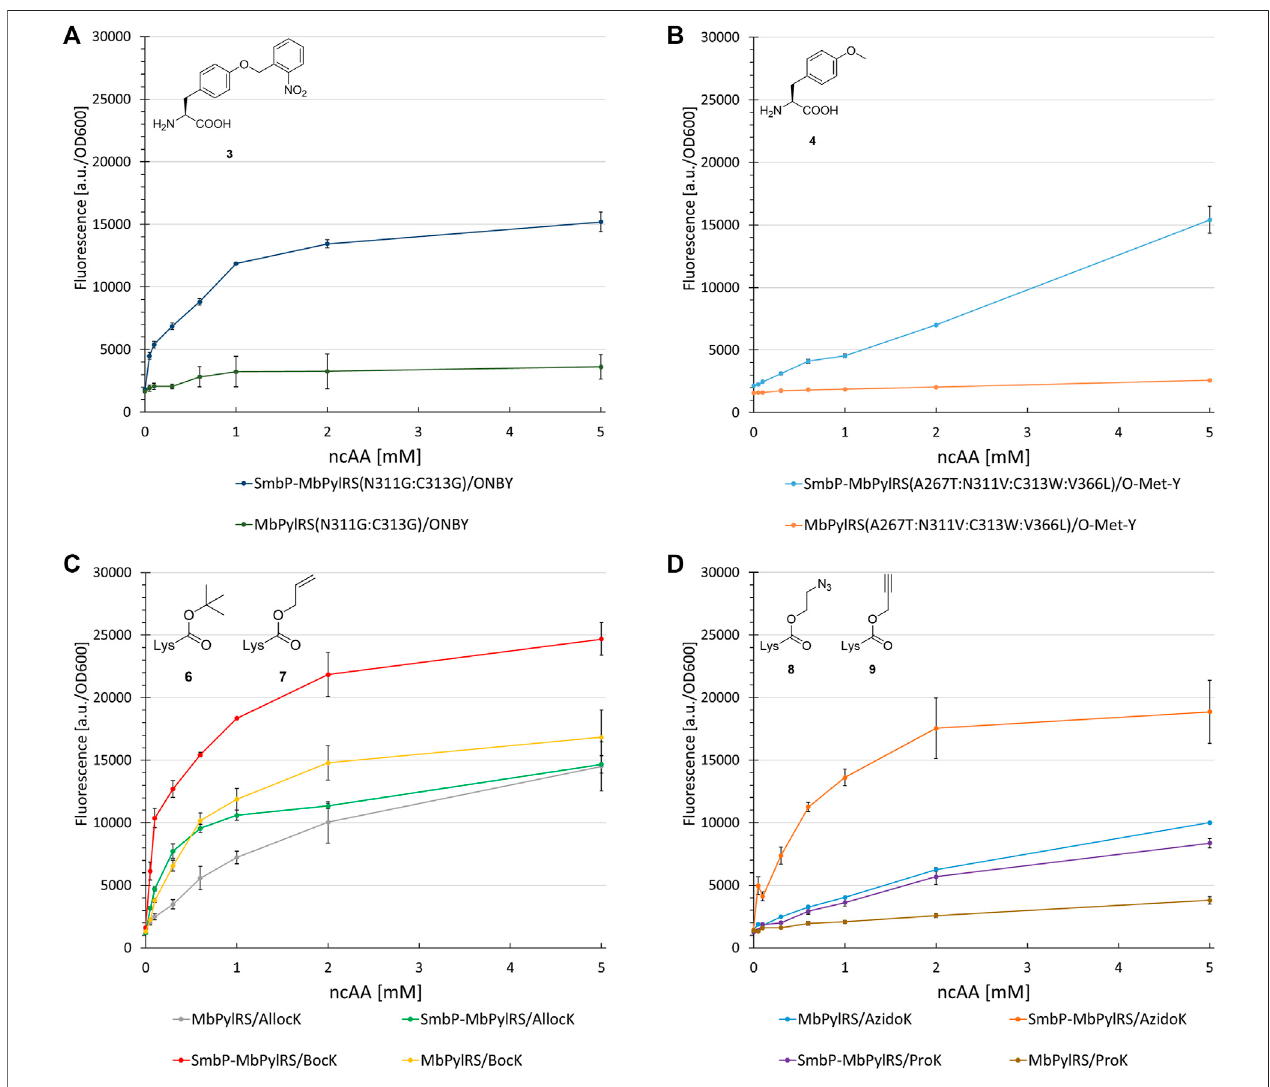
FIGURE 8 | Concentration dependent unnatural protein production for different combinations of SmbP- Mb PylRS/ Mb PylRS co-expression and ncAAs. Endpoint measurements for ncAA concentrations of 0.05, 0.1, 0.3, 0.6, 1, 2, and 5 mM.